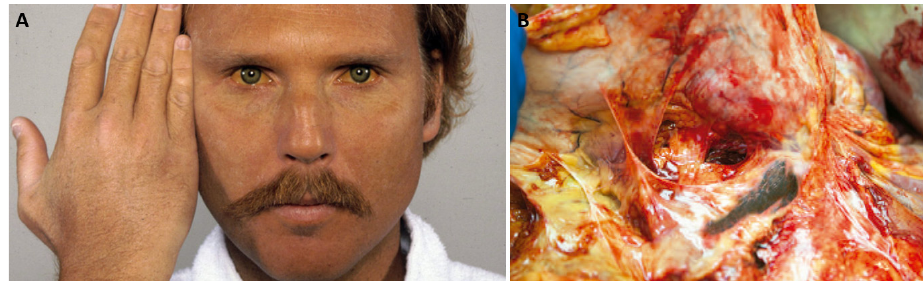
Figure 9. Skin hyperpigmentation—bronze coloration ( A ), a black ‐ greyish, rigid pancreas ( B ). Reprinted from ( A )—[313] and ( B )—[314]. Reprinted from ( A )—[313] and ( B